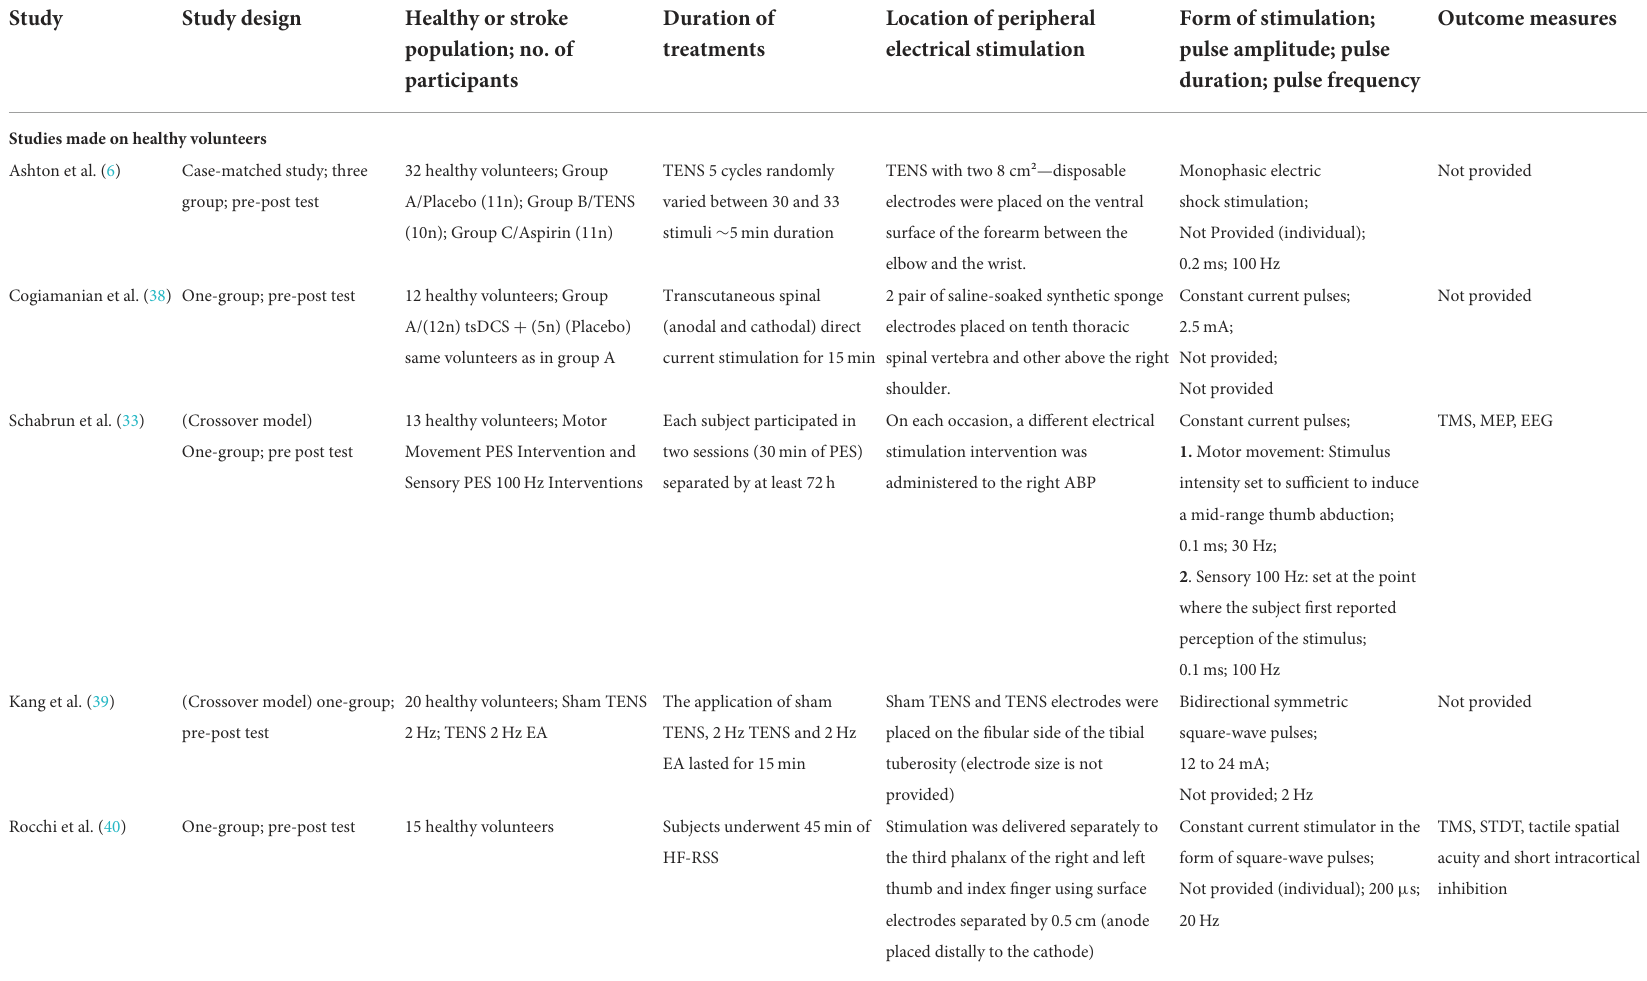
TABLE 2 Peripheral electrical stimulation effect—characteristic